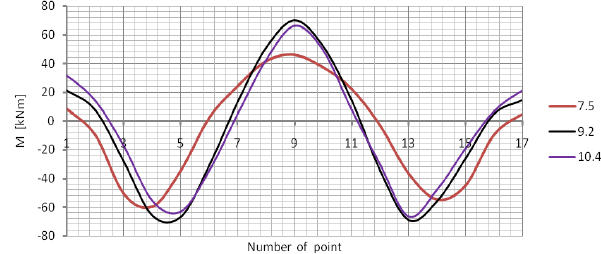
Figure 4 : Distribution of contact forces between the subsystems and also the R3 measuring base of the shell.